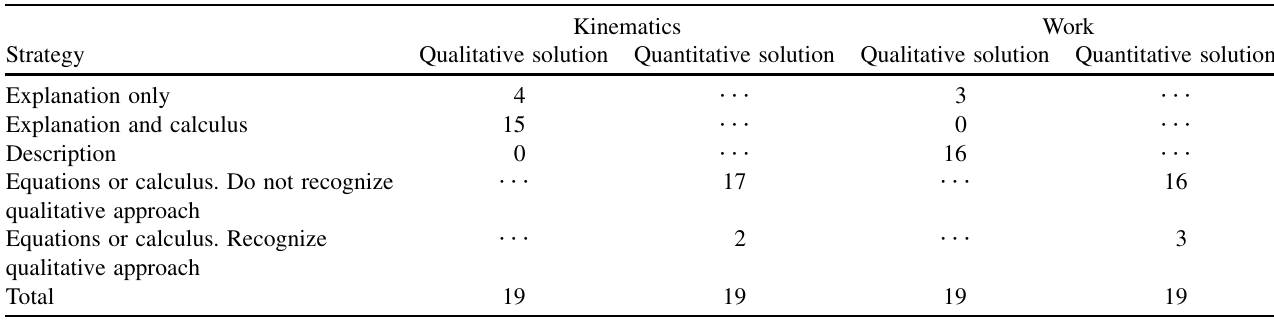
TABLE VII. Comparison of strategies when handling tasks, from kinematics and work, posed in symbolic form.